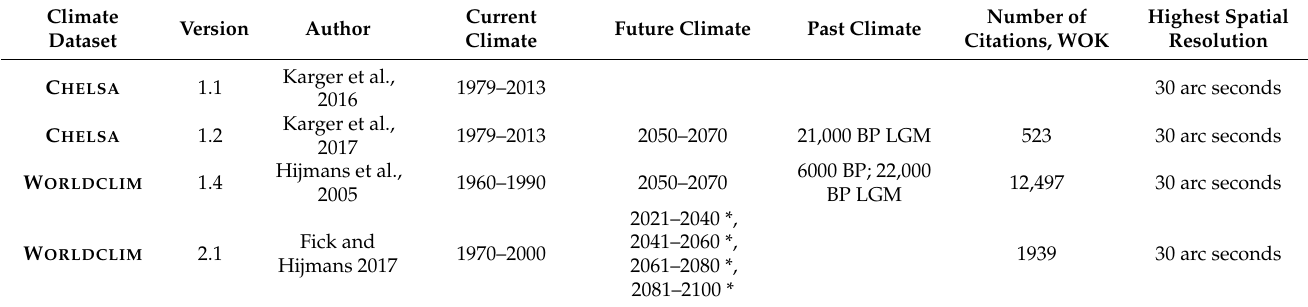
Table 1. Description of climate datasets and their respective versions used for comparison of model performance. Number of citations were last accessed in Web of Knowledge (WOK), March 2021. * Only available at 10 arc minutes, 5 arc minutes, and 2.5 arc minutes